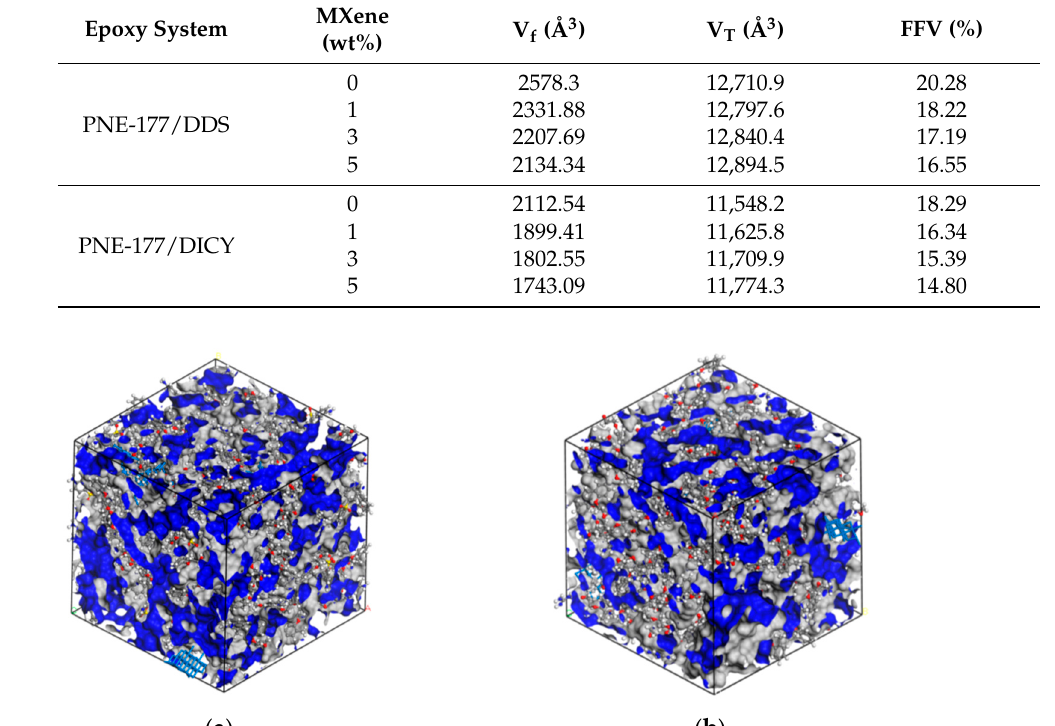
Table 5. The free volume parameters of PNE-177/DDS and PNE-177/DICY systems.